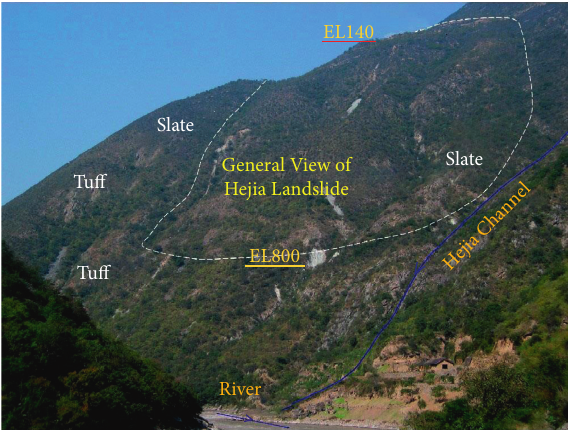
Figure 1: General view of the Hejia